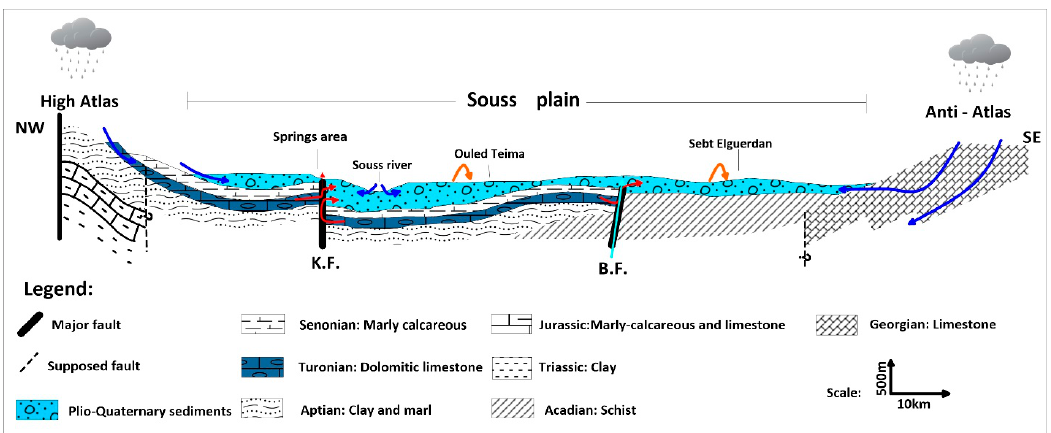
Figure 9. Schematic of groundwater flow in the Souss-Massa aquifer system. Shallow Plio-Quaternary and deep Turonian aquifers are shown in sky blue and desert blue colors, respectively [50].